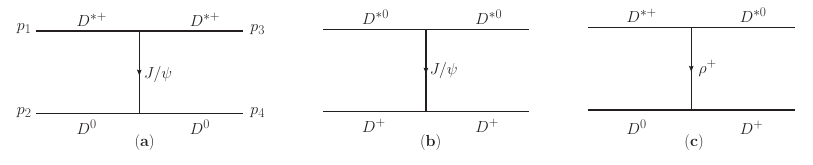
Figure 1. Diagrams considered for the interaction vector-pseudoscalar ( VP